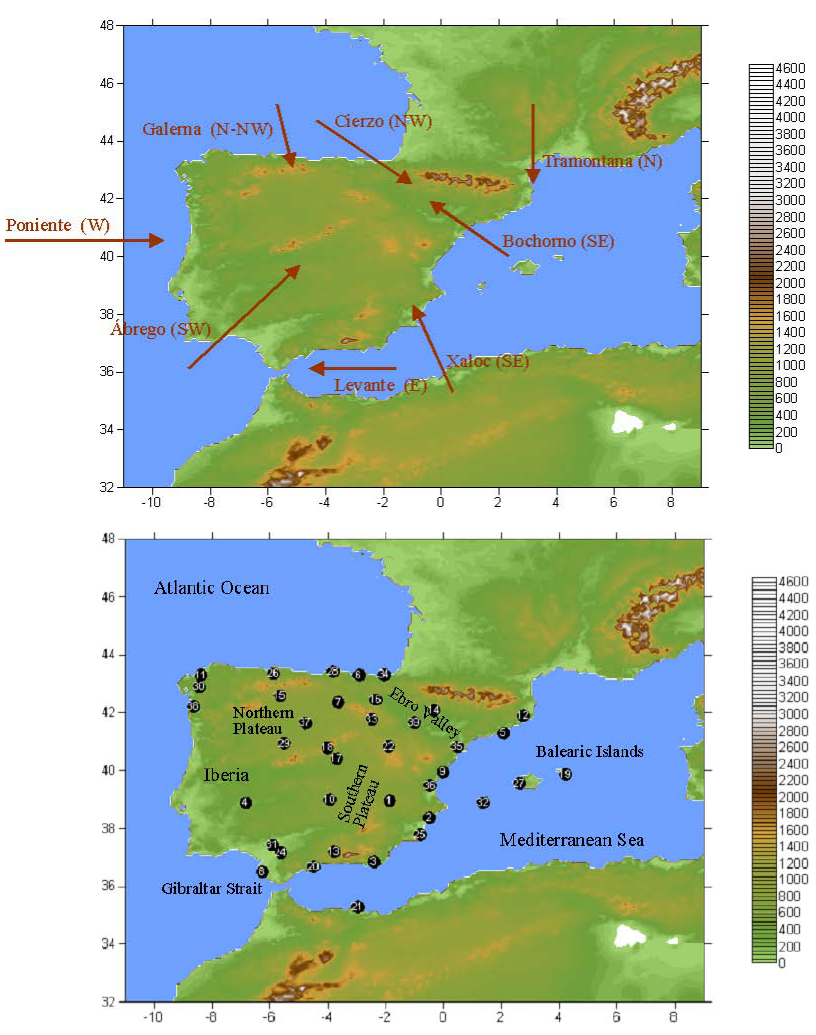
Fig. 1. (a) The Iberian Peninsula with typical winds and directions superimposed. This figure is available in colour online. (b) Circles indicate the wind stations for the Iberian Peninsula with its orography detailed. The station codes are shown in Table 1. The x-axis corresponds to longitude, positive (negative) for degree East (West). The y-axis to latitude, positive for degree